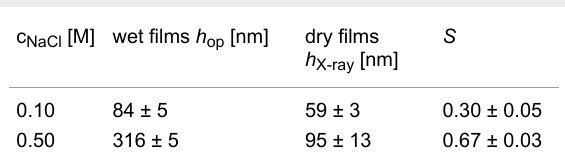
Table 2: Thicknesses (ellipsometry (wet films), h op , and X-ray reflec- tivity (dry films), h X-ray ) and swelling ratio, S , for (PDADMAC + PSS) N multilayers ( N = 12) formed from solutions with two different ionic